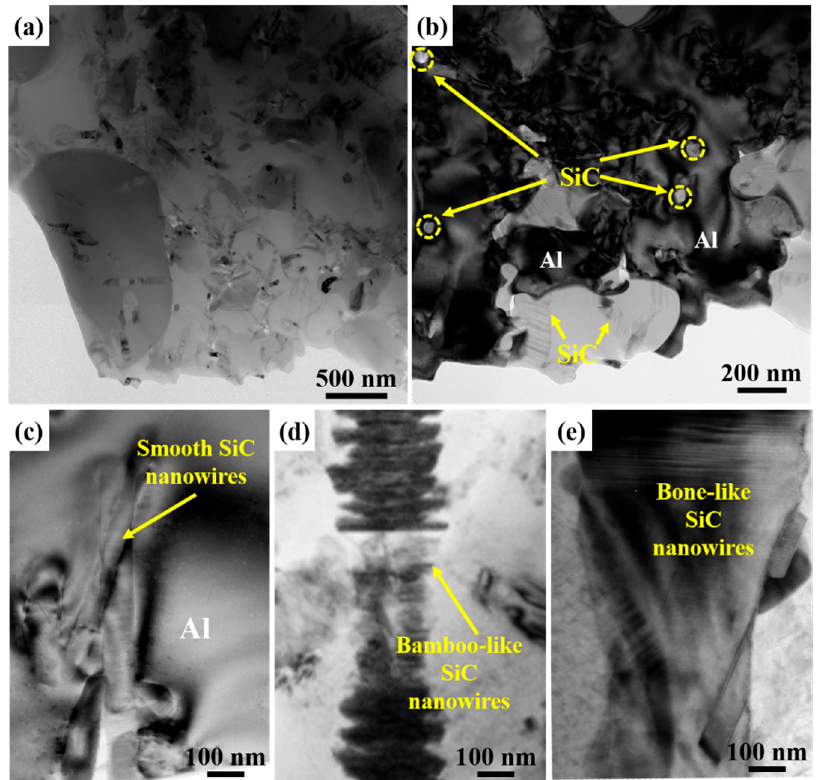
Figure 8. The TEM microstructure of SiCnws/6061Al composite. ( a ) Low magnification image of 100D SiCnws/6061Al, ( b ) SiC nanowires located within the Al grains in the 100D SiCnws/6061Al, ( c ) Smooth SiC nanowires in the 100D SiCnws/6061Al, ( d ) Bamboo-like SiC nanowires in the 250D SiCnws/6061Al, ( e ) Bone-like SiC nanowires in the 450D SiCnws/6061Al. The interfacial microstructure between SiC nanowires and the Al matrix was further observed by HRTEM, as shown in Figure 9. Selective electron diffraction patterns and their calibration results at the SiC/Al interface were given in Figure 9b,c, respectively. The calibration results showed that there were only diffraction spots of SiC and Al, which were similar to the results of micron SiC particles [50], nano SiC particles [51] and graphene [48] reinforced aluminum matrix composites prepared by pressure infiltration, and no interface products (such as Al 4 C 3 , SiO 2 or Al 2 O 3 ) were found [52–55], which showed that SiC nanowires were not damaged during the preparation process.